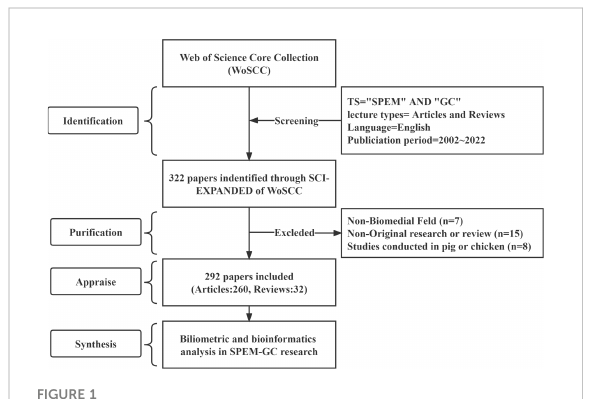
FIGURE 1 Literature search and screening fl